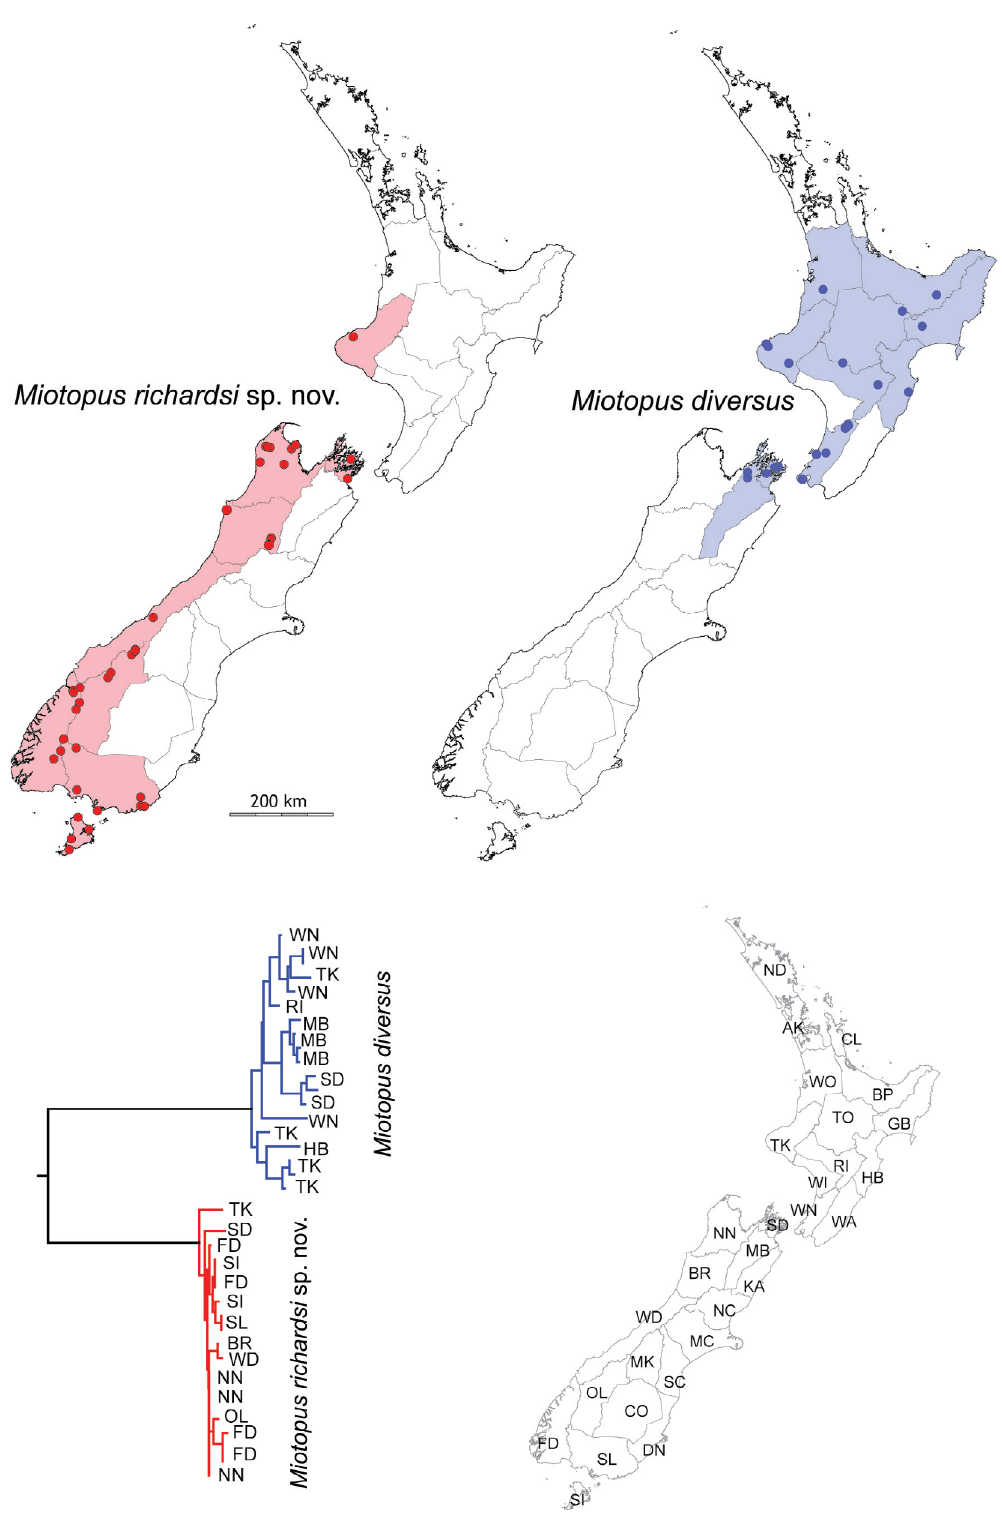
Fig. 4. known distributions of Miotopus richardsi sp. nov. (red) and M. diversus (hutton, 1896) (blue). Reciprocally monophyletic clusters of mtDNA sequences (835 bp COI, ML, HKY, with outgroup removed) of samples that encompass morphological and geographic diversity of the two taxa. Spot locations are indicated (circles) within the relevant New Zealand entomological (Crosby)